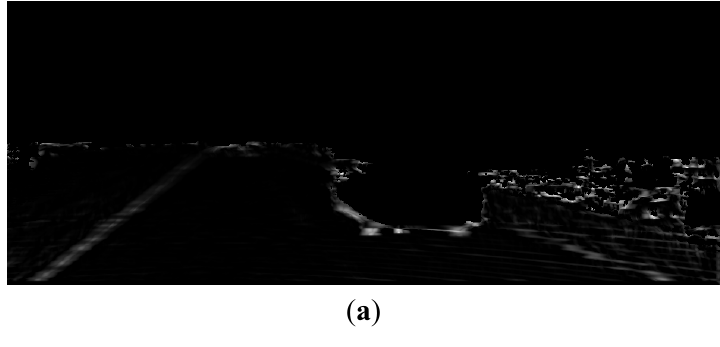
projection map; ( b ) ‘DBD’ pattern response on W projection W